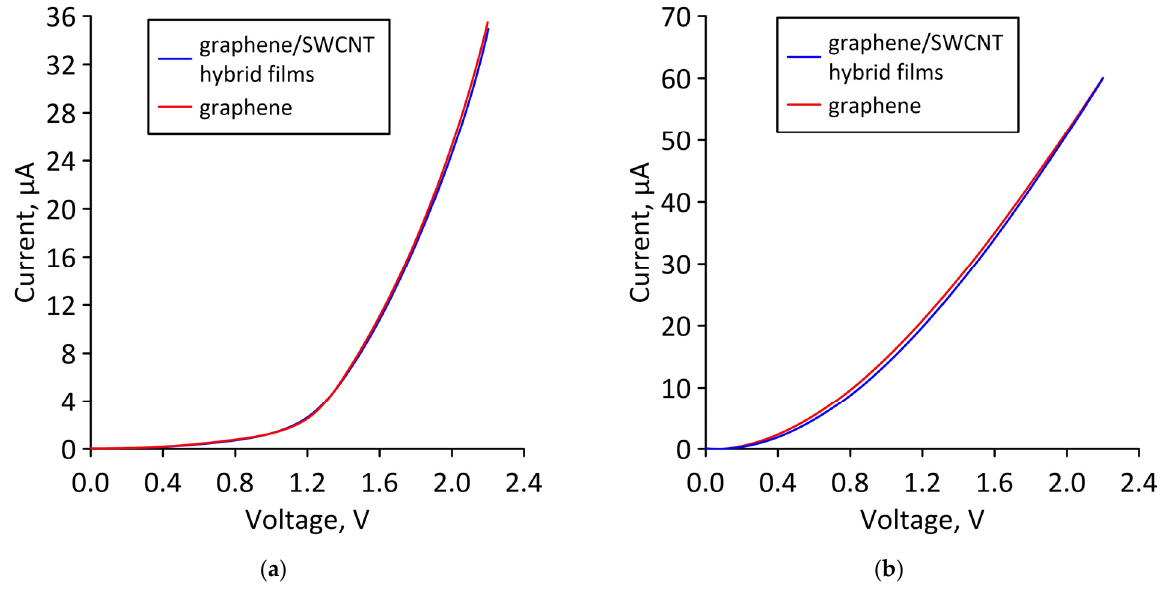
Figure 12. Current-voltage characteristics of bilayer graphene-SWCNT (12,6) hybrid films with island topology: ( a ) model V1 at axial stretching by 14%; ( b ) Model V2 at axial stretching by 10%.